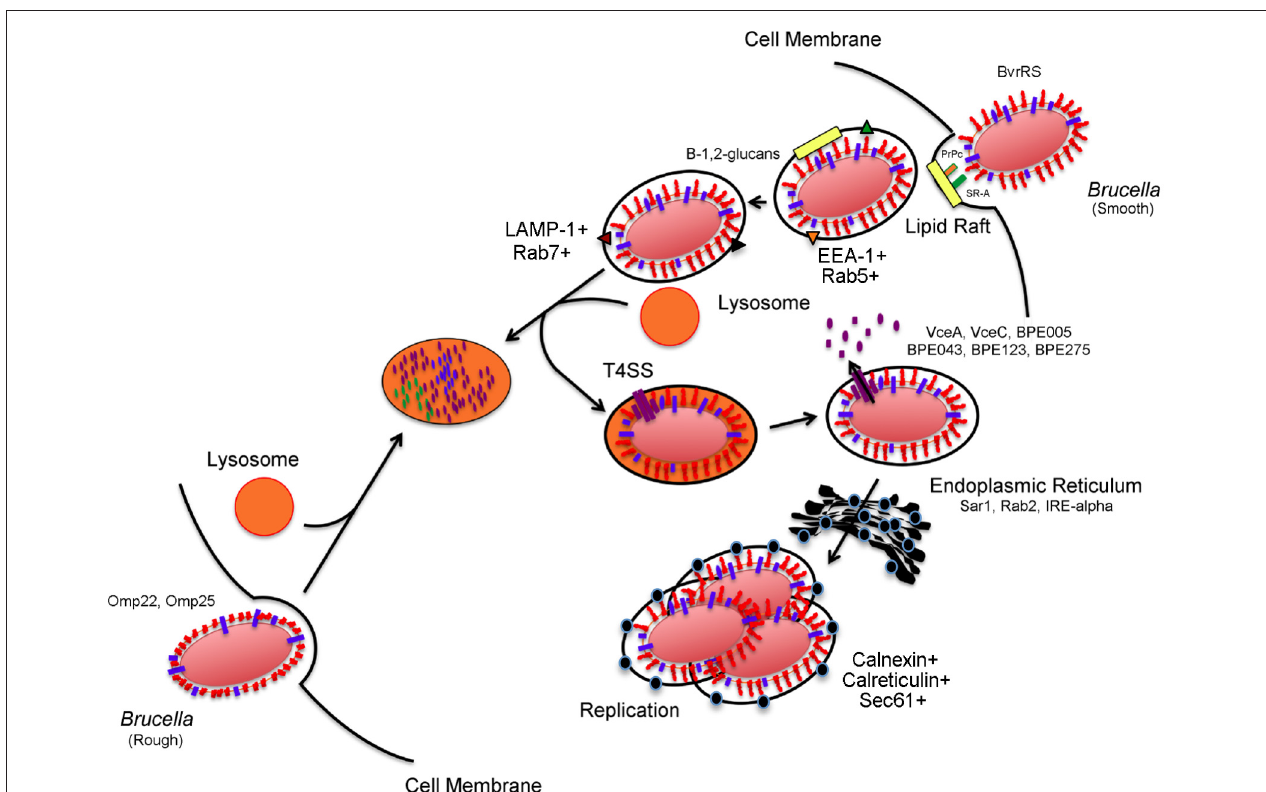
FIGURE 1 | Brucella invasion and intracellular trafficking in host mammalian cells. Smooth Brucella is internalized in a vacuole following interactions with host cell lipid rafts, PrPc, and SR-A. Brucella derived β -1,2-glucans act by remodeling surface vacuolar lipid-rich domains. The vacuole then fuses transiently with host cell lysosomes for replication- competent bacteria. These transient interactions lead to activation of acid-dependent genes, including type 4 secretion system. Type 4 secretion